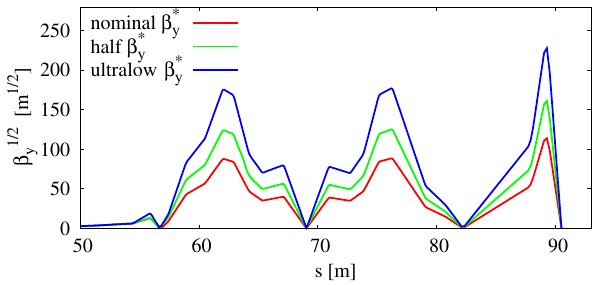
FIG. 1. β y function along the ATF2 beam line in the case of nominal β (cid:1) y , half β (cid:1) y and ultralow β (cid:1) y